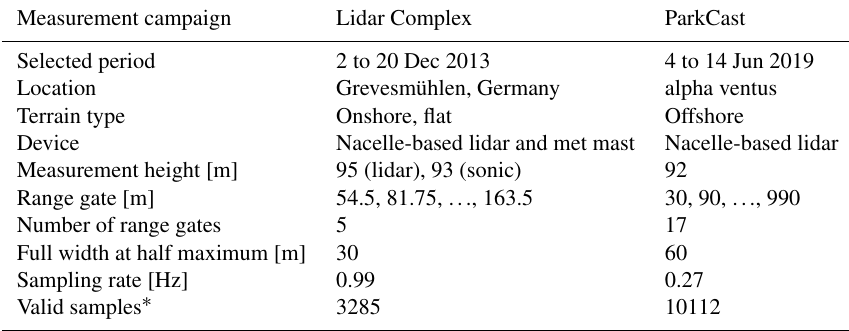
Table 2. Summary of measurement setups.